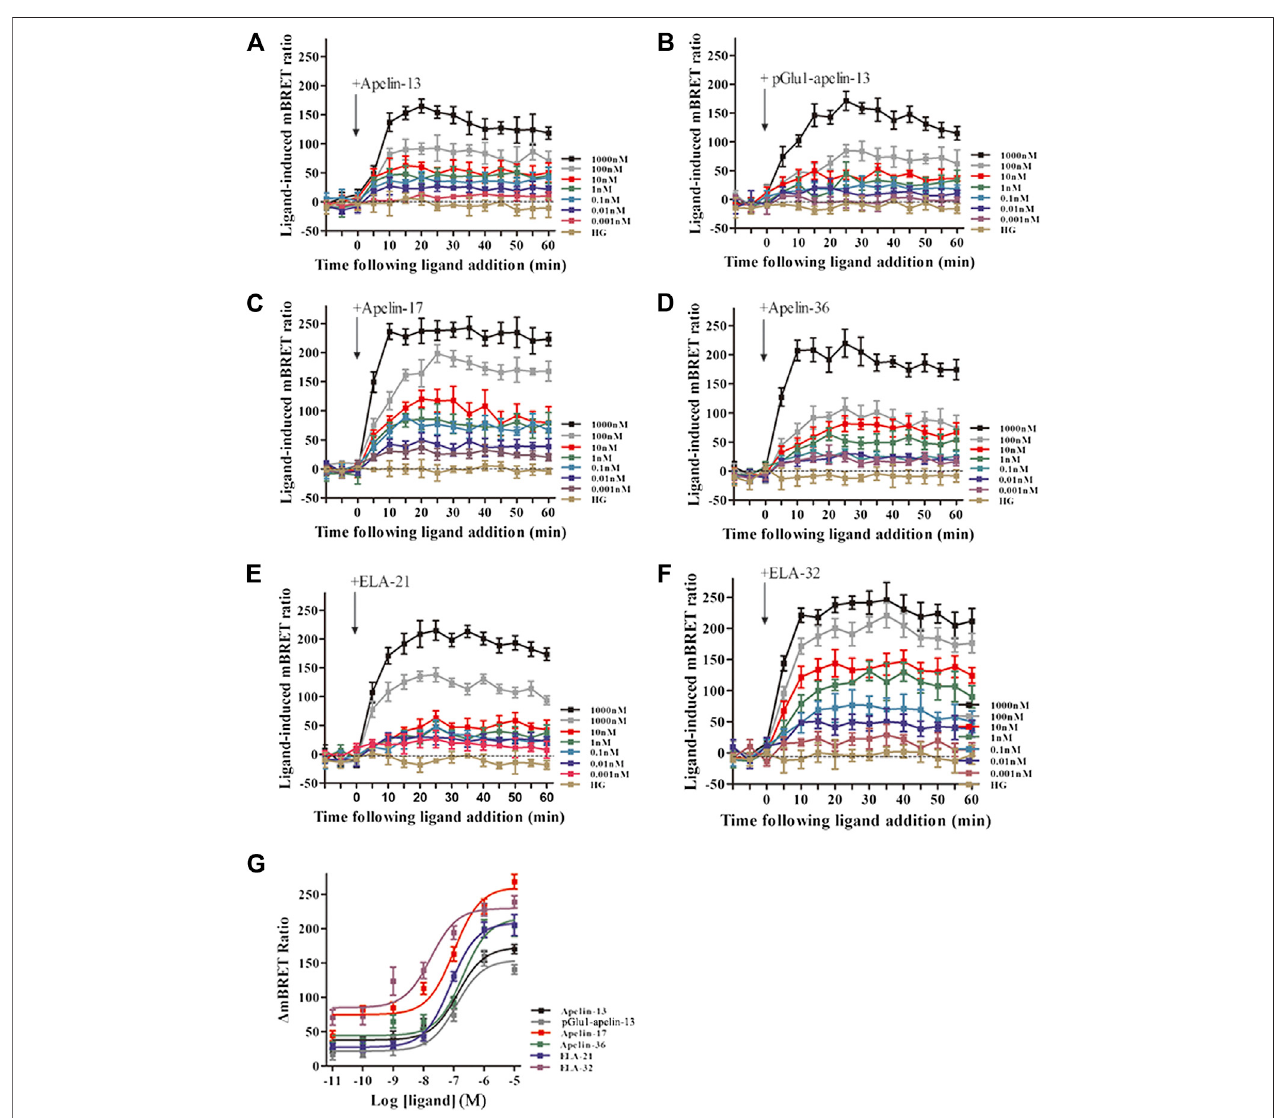
FIGURE 7 | The time-response curve (A – F) and dose-response curve (G) of interactions between APJ and β -arrestin2 induced by the six agonists in different concentrations,obtainedfromreal-timedynamicBRETdeterminations. p < 0.05wasconsideredasstatisticallysigni fi cant.Controlgroup(HG,Cellswerestimulatedwith high glucose). In HEK293 cells expressing APJ and β -arrestin 2, the dose-response curves of the six peptides at 20 min were observed. The data represent means ± SEM of four independent experiments. Statistical analysis ( Supplementary Table S6 ).